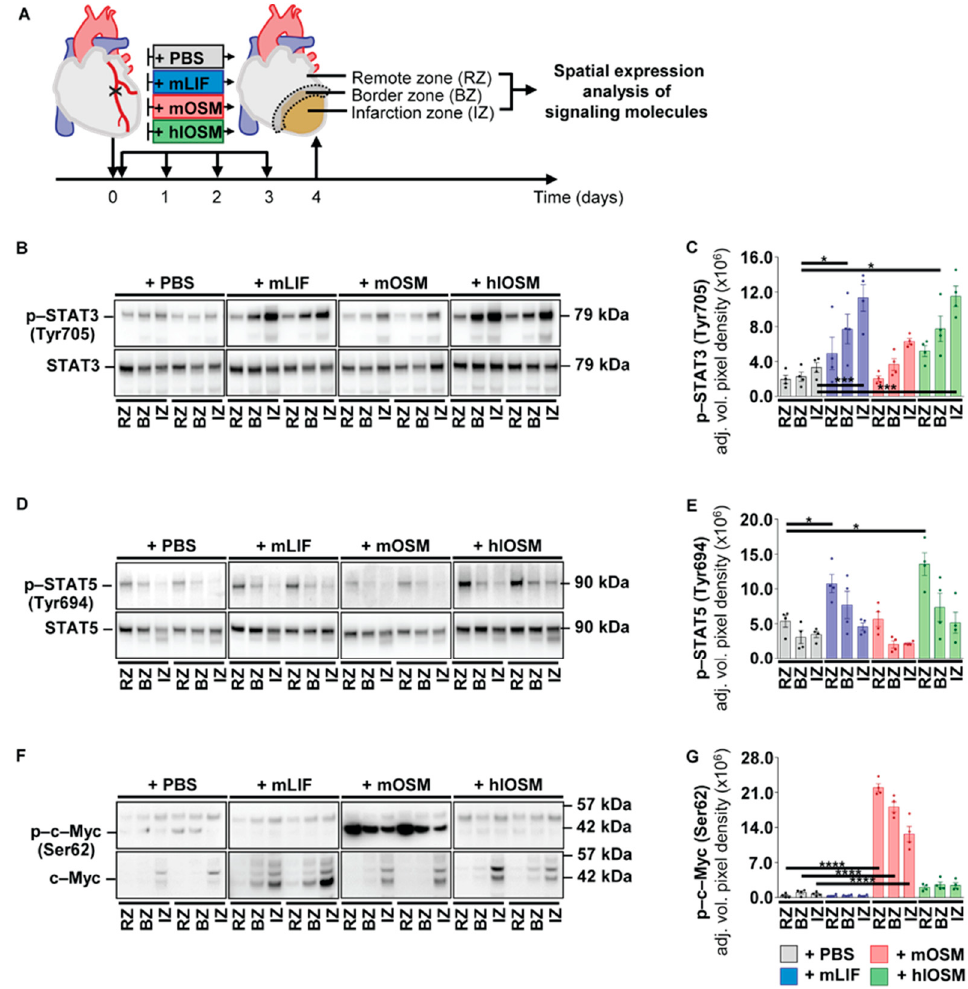
Figure 5 . Post-infarction administration of mLIF, mOSM and hlOSM modulates the activation of STAT3, STAT5 and c–Myc at distinct sites of the myocardium. ( A ) Schematic illustration of systemic post-infarction administration of mLIF, mOSM and hlOSM in mice during the first three days of cardiac remodeling. At Day 4 post-MI, hearts were harvested, fractionated into a non-infarcted remote zone (RZ), border zone (BZ) and an infarction zone (IZ) to perform spatial expression analysis of signaling molecules via immunoblotting. Two representative images and semi-quantitative analysis of immunoblots of ( B , C ) p–STAT3 (Tyr705), ( D , E ) p–STAT5 (Tyr694) and ( F , G ) p–c–Myc (Ser62) in RZ, BZ and IZ of mice ( n = 4 for all groups). Semi-quantitative analysis of immunoblots is based on the adjusted mean volume pixel density of bands. Statistical analysis was performed by one-way ANOVA together with Bonferroni post-test comparisons in order to monitor myocardial site-specific effects upon administration of PBS, mOSM, mLIF and hlOSM. Asterisks indicate Bonferroni post-hoc test significances between cytokine- and PBS-treated mice in RZ, BZ and IZ with * p < 0.05, *** p < 0.001 and **** p < 0.0001. Data are presented as mean ± sem.